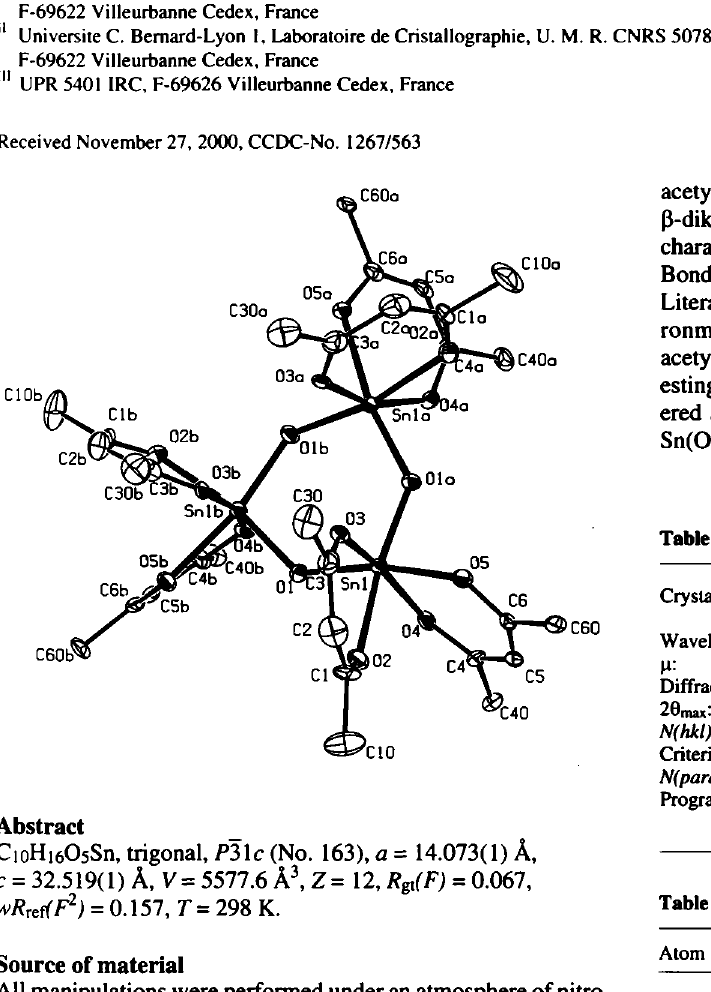
Table 2. Atomic coordinates and displacement parameters (in Ä 2